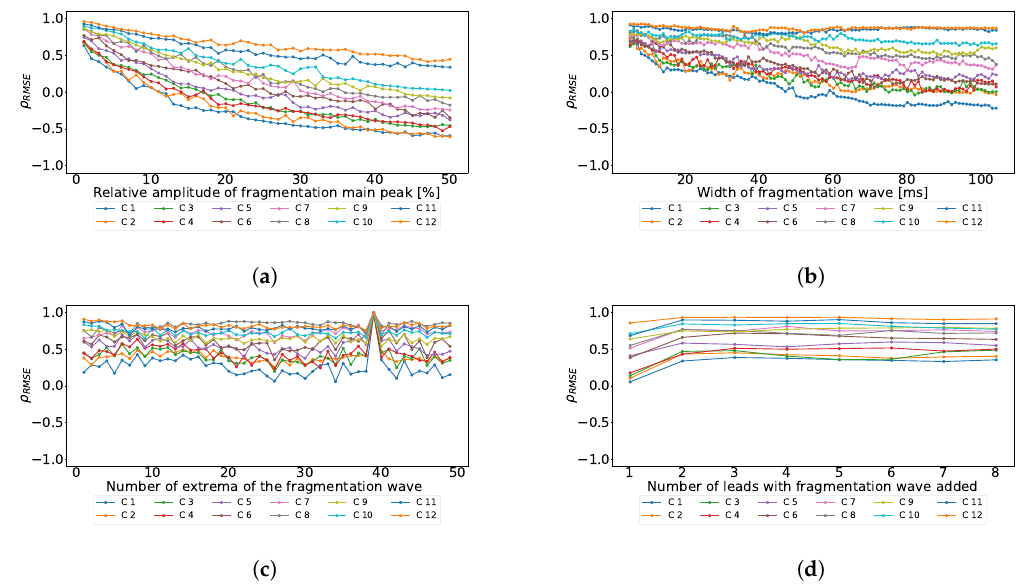
Figure 11. Effect of the different parameters of the subrogated fragmented wave over the ρ RMSE coefficient using the ICA twelve-lead model. Values lower than 0 correspond with RMSE higher in the ECG than in the principal components, values higher than 0 correspond with RMSE higher in principal components than in the ECG. ( a ) Effect of the fragmented wave amplitude; ( b ) Effect of the fragmented wave width; ( c ) Effect of the cycle number of fragmented waves; ( d ) Effect of the number of affected